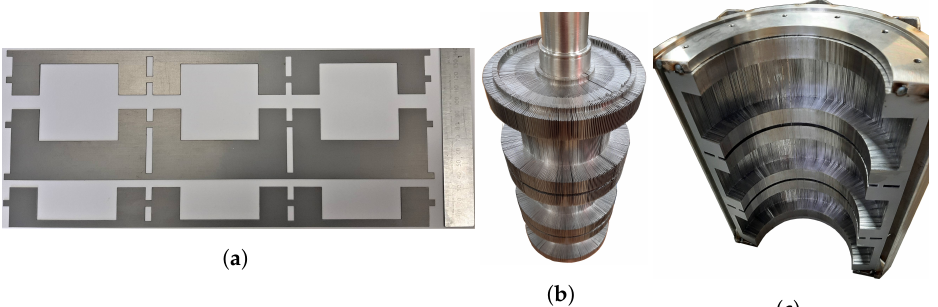
Figure 9. ( a ) Laminations for the rotary transformer; ( b ) rotor without end plate; ( c ) stator half during stacking.